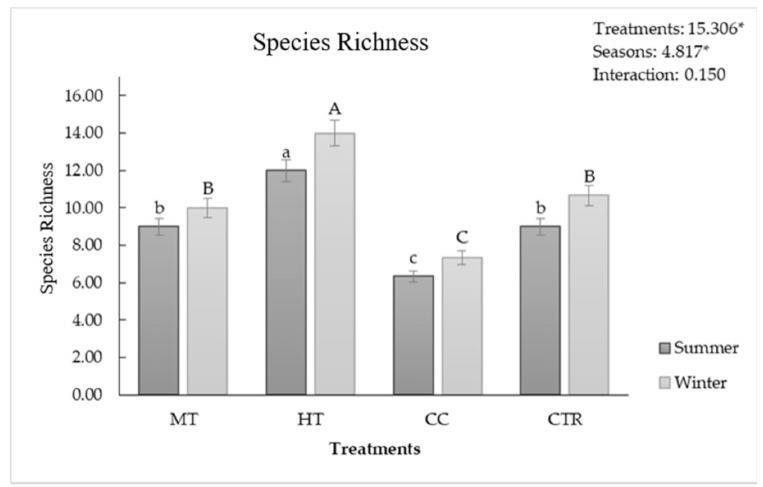
Figure 3. Species richness in soil under differently managed plots of a Pinus laricio plantation. HT: intensive thinning; MT: moderate thinning; CC: clear cut; and CTR: control. Two-way ANOVA shows the effects of treatments, seasons, and their interactions. Lowercase letters and capital letters show significant differences among the management intensities (Tukey’s test, p -level ≤ 0.05) in summer and winter, respectively. * p < 0.05. The data are the means of two consecutive years (2014 and 2015).